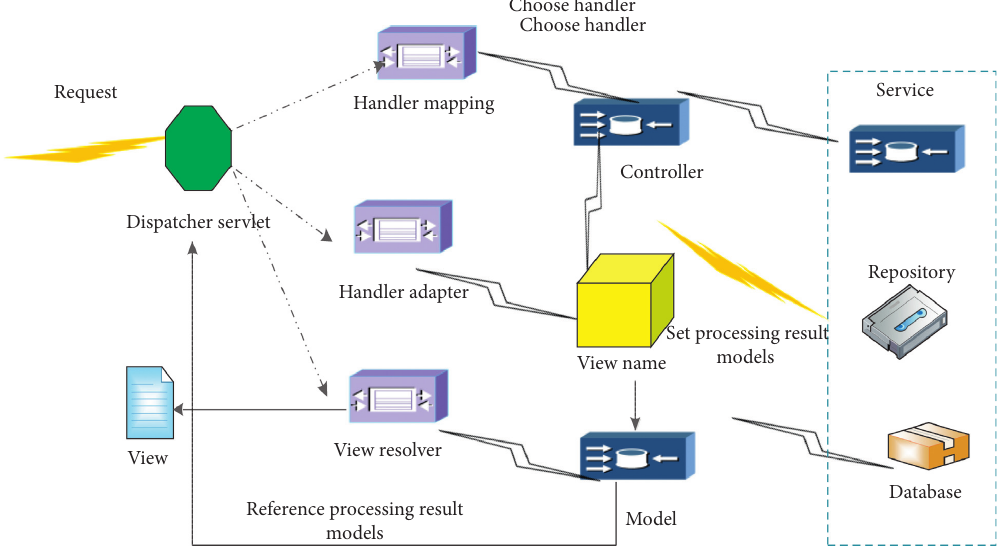
Figure 1: Request processing flow in spring MVC.